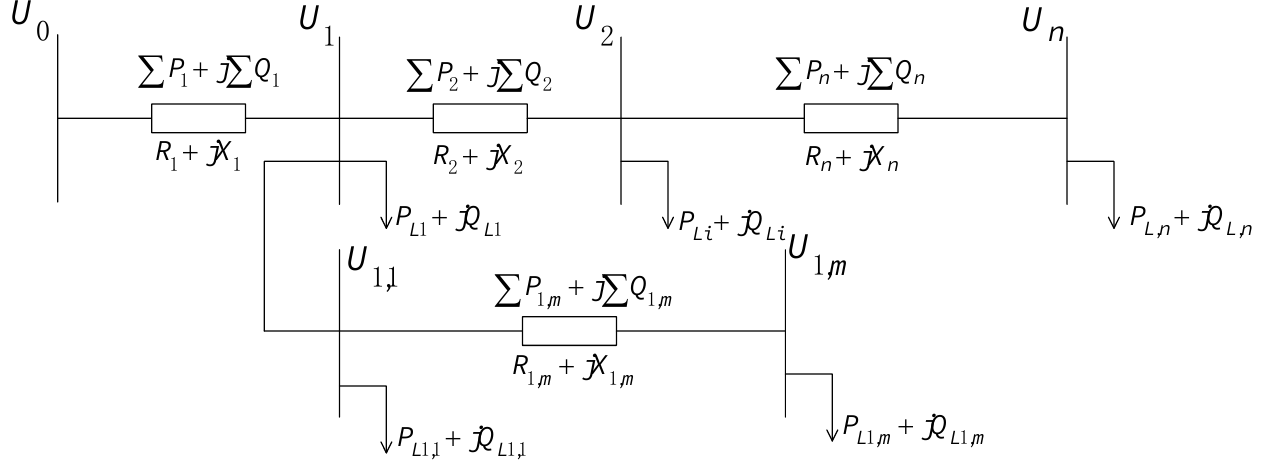
Figure 1. Equivalent diagram of distribution network.